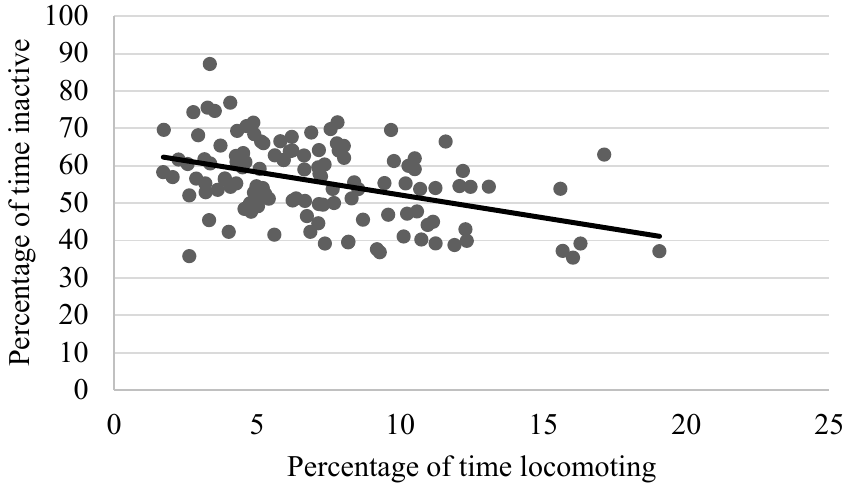
Figure 7. Negative relationship between the mean percentage of time spent locomoting and time spent inactive. Chimpanzees that spent more time inactive exhibited lower levels of locomotion ( p ≤ 0.05).